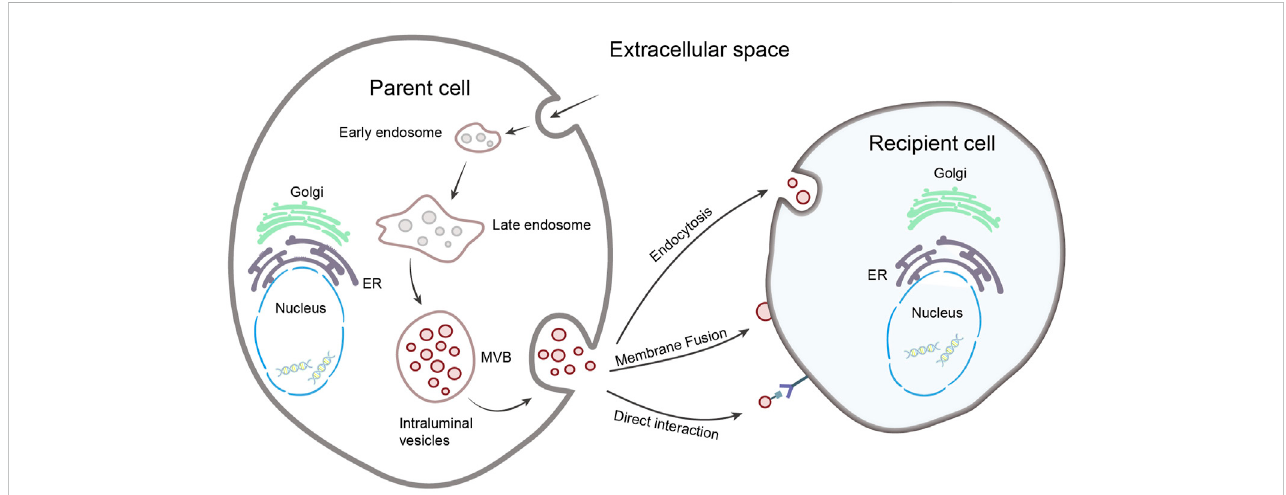
FIGURE 1 Biogenesis and uptake of exosomes. The parent cell membrane invaginates to form early endosome, matures to late endosome, and transforms into multivesicular body (MVB), contain intraluminal vesicles. The MVB fuse with the cell membrane and release exosomes. After exosomes are released, information can be transmitted to recipient cells through membrane fusion, direct interaction and endocytosis.